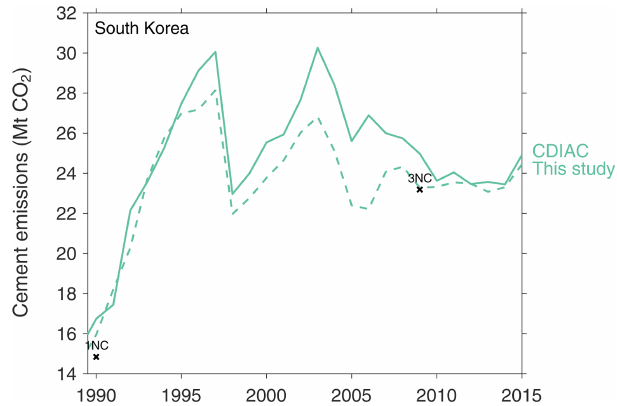
Figure D19. Indonesian clinker production and derived consump- tion, 2000–2012.